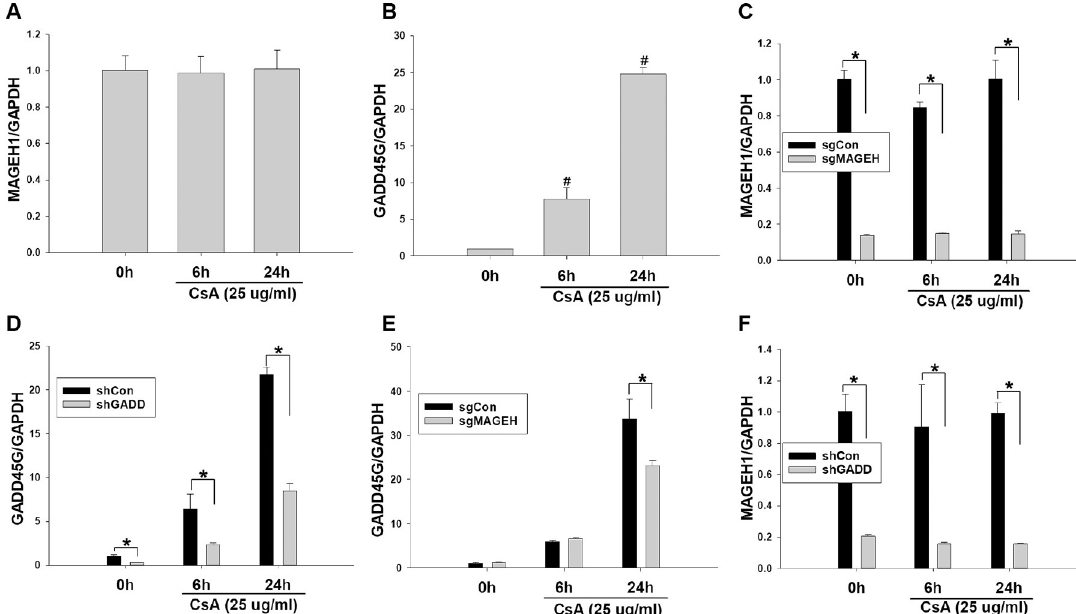
Fig 4. Quantitative real-time PCR for mRNA expression in CsA-treated HRE cells. (A) Time course of MAGEH1 gene expression in response to CsA treatment. HRE cells were incubated with 25 μ g/ml CsA for the indicated time. n = 3 each. (B) Time course of GADD45G gene expression in response to CsA treatment. HRE cells were incubated with 25 μ g/ml CsA for the indicated time. n = 3 each. (C) Silencing of MAGEH1 gene expression in sgMAGEH-HRE cells. n = 3 each . (D) Silencing of GADD45G gene expression in shGADD-HRE cells. n = 3 each . (E) Effect of silencing of MAGEH1 on GADD45G expression in sgMAGEH-HRE cells. n = 3 each. (F) Effect of silencing of GADD45 G on MAGEH1 expression in shGADD-HRE cells. n = 3 each. Data were expressed as mean ± SD. One- way ANOVA followed by Bonferroni’s post-hoc comparisons tests (Panels A, B) or Student’s t-test (Panels C-F) was used to compare groups. A p value < 0.05 was considered significant. #p < 0.05 vs. all other groups; � p < 0.05 between groups. GAPDH served as an internal control. sgMAGEH represents single guide RNA constructs to knockdown MAGEH1; sgCon, control single guide RNA constructs targeting no known genes; shGADD, short hairpin RNA constructs to knockdown GADD45G; shCon, control short hairpin RNA constructs targeting no known